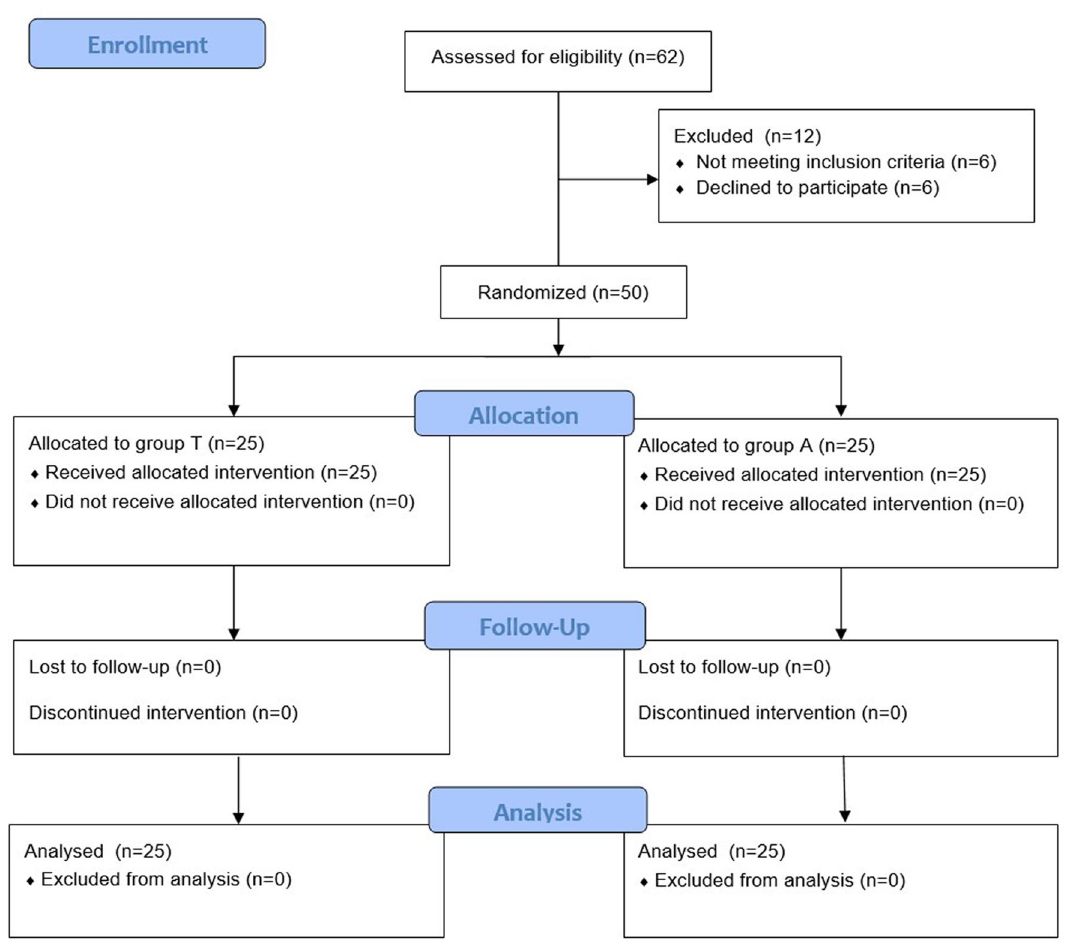
Figure 1. Flow-chart describing patient recruitment, randomization, and withdrawal. Group T: Trapezius muscle group maintaining TOF (train-of-four) count 1–3 based on acceleromyography at the trapezius muscle. Group A: Adductor pollicis muscle group maintaining TOF count 1–3 based on acceleromyography at the adductor pollicis